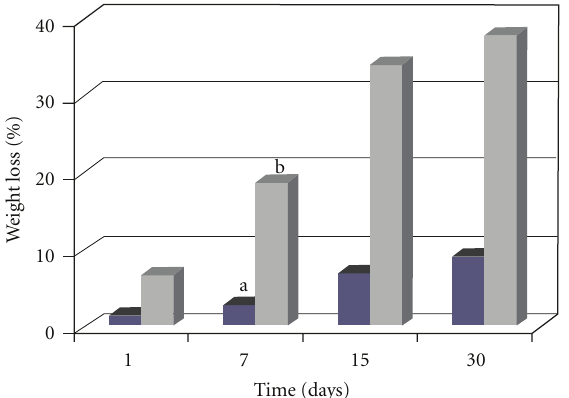
Figure 8: Biodegradation by bacteria ( B. cereus ) of (a) PAN, (b) PAN/MMT (5%w/v) on time versus weight loss.